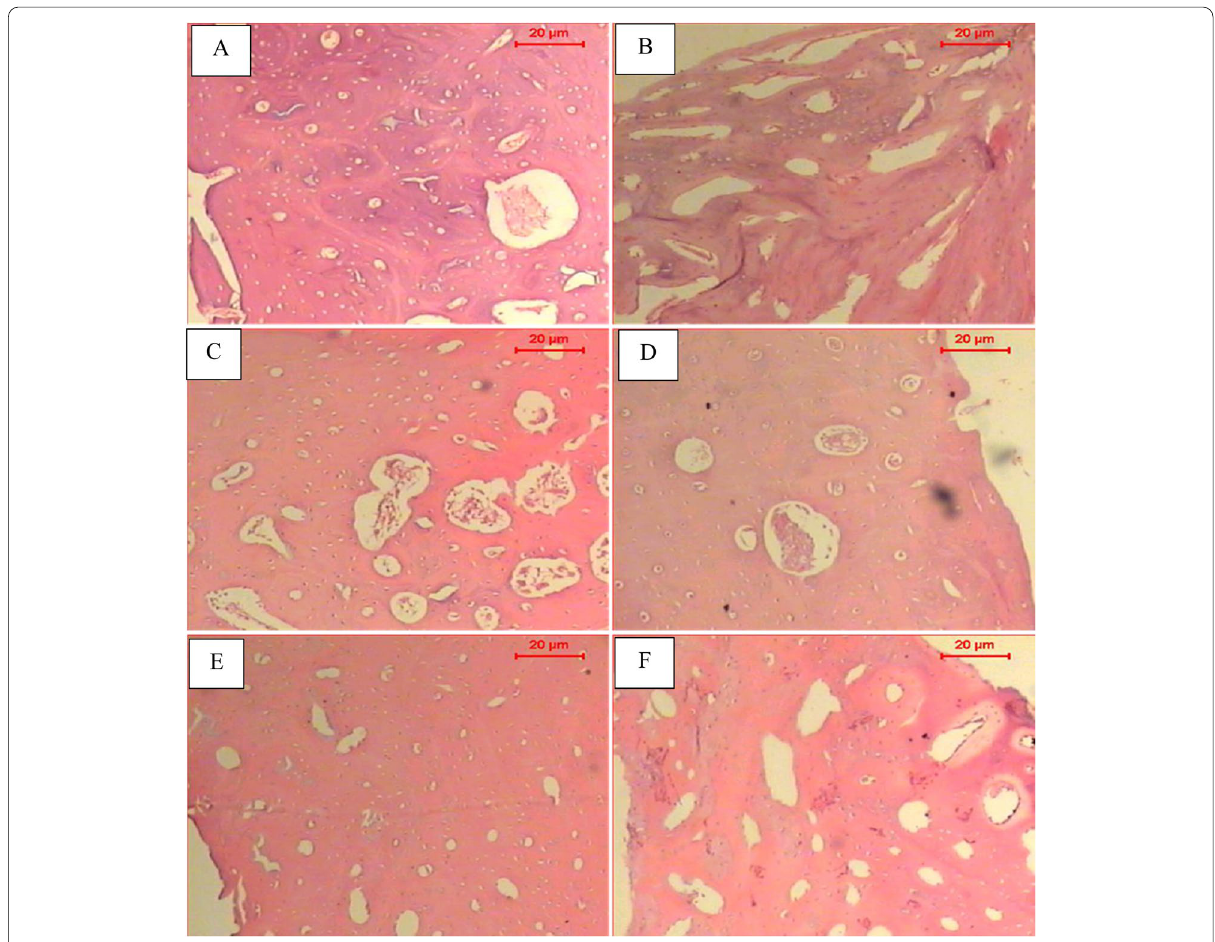
Fig. 10 Histopathological sections of rabbits transplanted by hDP‑MSCs and ceramic nanocomposites scaffold. Sections of bone of A tested dental pulp stem cells (DP‑MSCs) with ceramic nanocomposites (C1) after 4 weeks show nodules like shape of new formed bone and few vacuoles that are filled with connective tissue. B Control of ceramic nanocomposites (C1) only after 4 weeks shows many of vacuoles surrounded by new formed bone. C Tested dental pulp stem cells (DP‑MSCs) with ceramic nanocomposites (C2). After 4 weeks, extensive regions of the mature bone showed in the defect parts. Note the collagen‑filled vacuole. D Control of ceramic nanocomposites (C2) only after 4 weeks shows thickness of bone regeneration in the defect. Few vacuoles that are filled with connective tissues. E Tested dental pulp stem cells (DP‑MSCs)